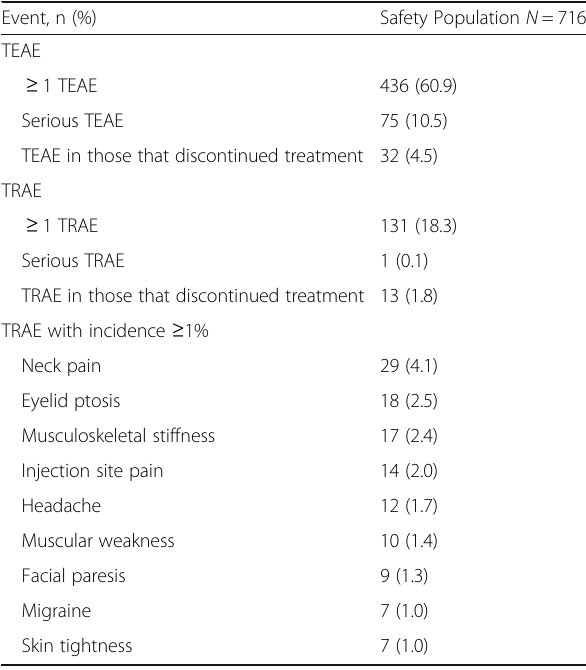
Table 3 Summary of TEAEs and TRAEs in Patients Receiving ≥ 1 OnabotulinumtoxinA Treatment Event, n